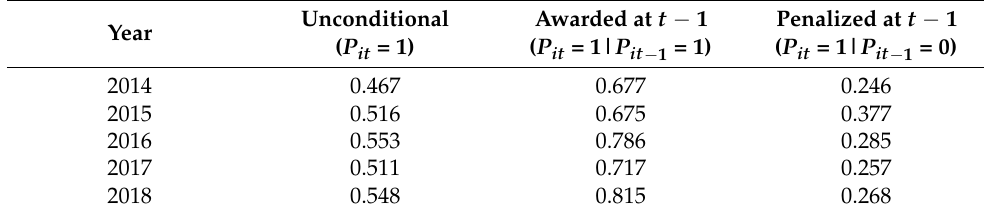
Table 4. Conditional and unconditional probabilities that a hospital will receive a